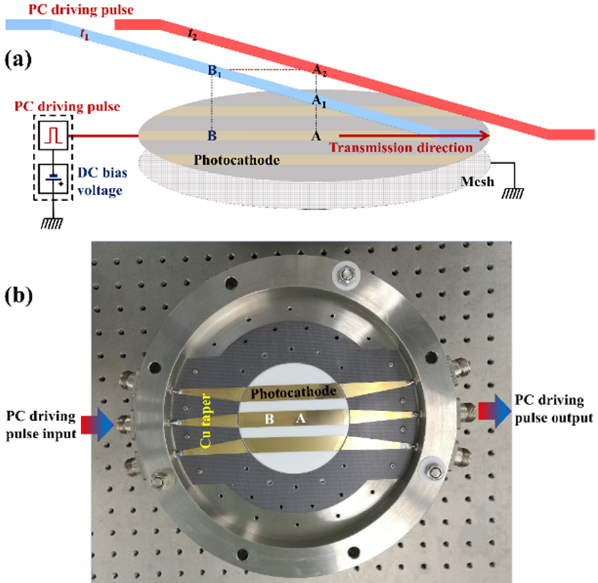
Figure 2. ( a ) Schematic diagram of the driving pulse transmission along the PC. ( b ) Photograph of the transmission PCs.